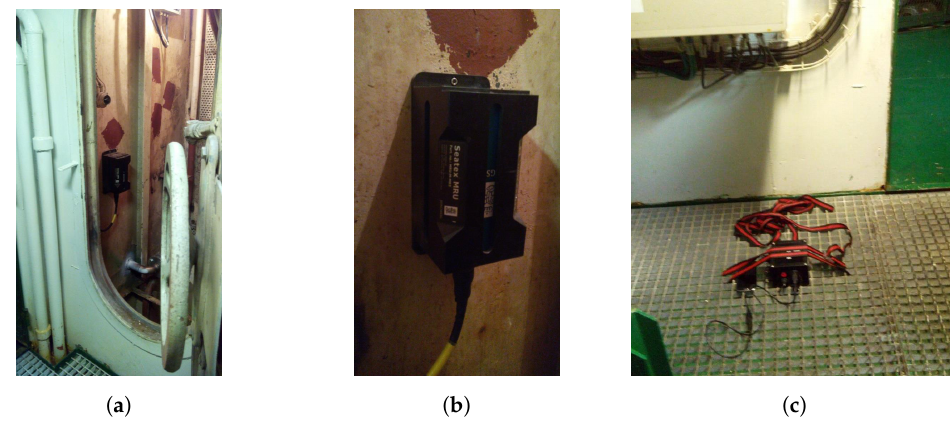
Figure 20. Installation for attitude data measurement validation on ship: ( a ) Motion Reference Unit (MRU) compartment; ( b ) MRU-5 from Seatex; ( c ) measurement node close to MRU.